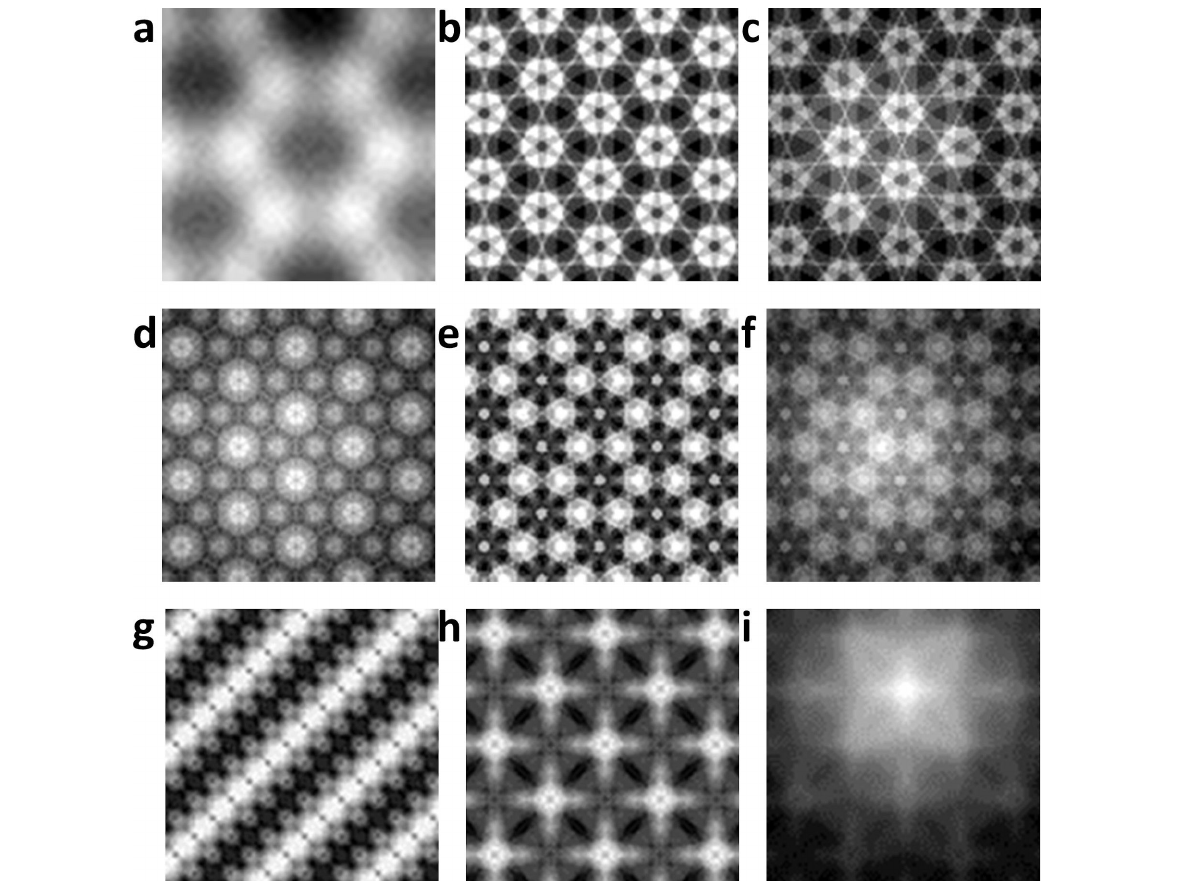
Figure 5: The interaction energy maps of graphite and gold samples obtained by molecular dynamics simulation. The size of the first image is 51 × 51 and the other images are 101 × 101. (a) The conical tip interacts with the graphite sample in AM mode. (b–f) The single Si atom tip interacts with the graphite sample at 7 Å. In (d) the cut-off distance of the tip–sample increases by 2 Å. In (e) the tip atom drops by 2 Å. (g) The hemispherical tip inter- acts with the gold sample. (h–i) The single Si atom tip interacts with the gold sample. In the simulations on the far-right column (c,f,i) we removed one atom from the sample surface.